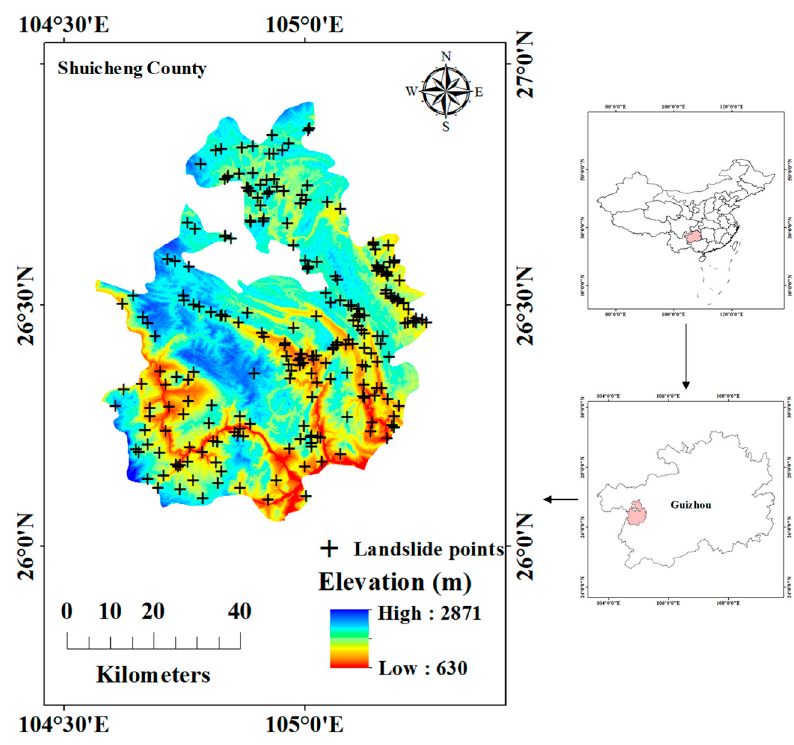
Figure 1. Location and landslide points of Shuicheng County, China.